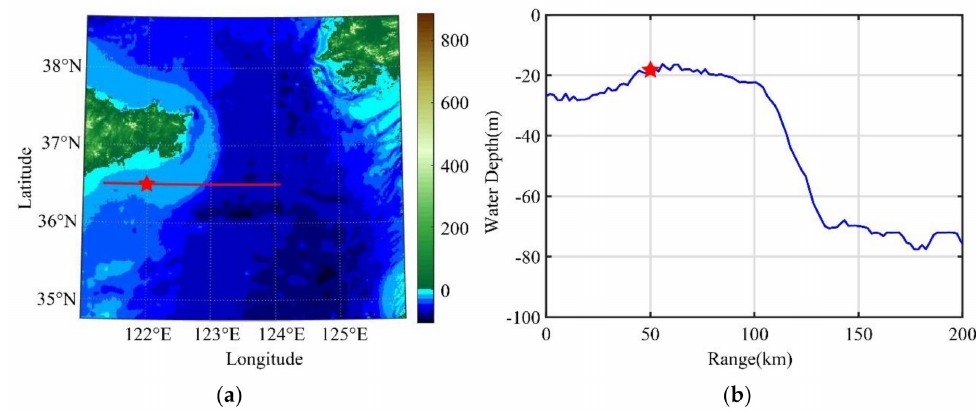
Figure 8. ( a ) The experimental area with survey line (red line). ( b ) The topographic perturbations along the survey line.